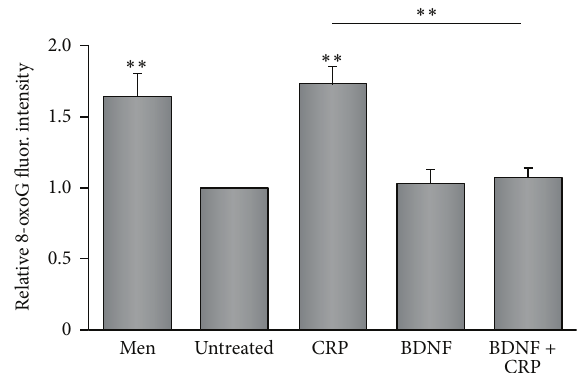
Figure 5: BDNF inhibits CRP-induced DNA damage. HMVEC- Cs untreated or treated with 25 𝜇 M menadione (Men), 25 𝜇 g/mL CRP (CRP), 10 ng/mL BDNF (BDNF), or BDNF and CRP (BDNF + CRP) and then fixed and stained with anti-8-oxoG antibodies. Fluorescent intensity for 8-oxoG stained nuclei was quantified and the histogram represents the normalized mean + SEM from 4 experiments. ∗∗ 𝑝 < 0.01 using one-way ANOVA and Tukey’s post hoc